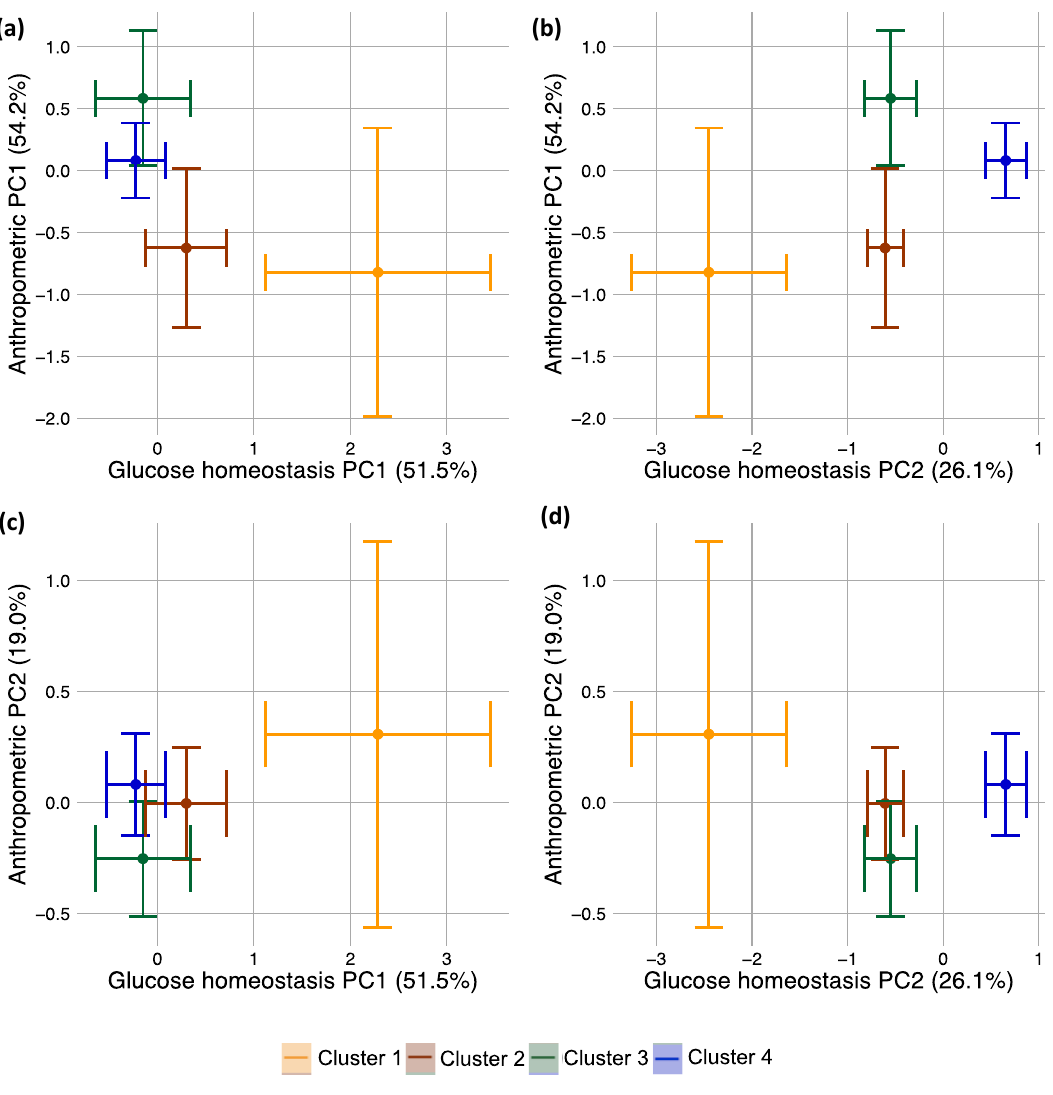
Figure 3. ( a – d ) Principal responses generated from principal components analysis of 1 year responses in individual parameters of both the glucose homeostasis and anthropometric parameter groups. PC stands for principal component. Points are model-adjusted means of each cluster from mixed models adjusting for sex; error bars are for standard errors. Percentages represent the amount of total variation in the data that is explained by a PC. ( a , b ) compare anthropometric PC1 against the glucose homeostasis PCs; ( c , d ) compare anthropometric PC2 against the glucose homeostasis PCs.